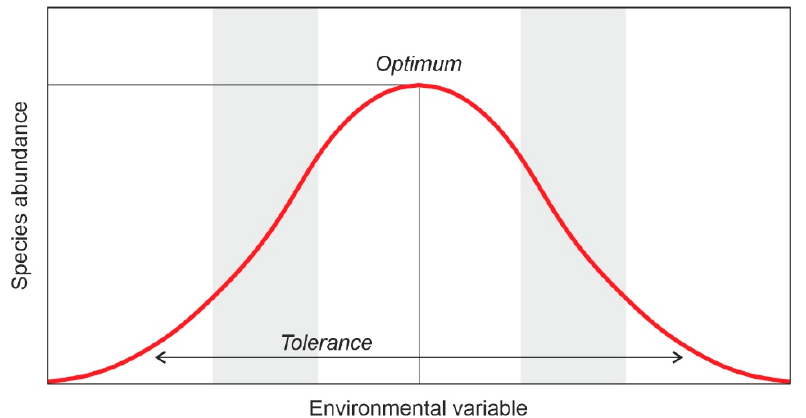
Figure 7. Gaussian curve displaying a hypothetical unimodal response of a species with respect to an environmental variable. The gray bands represent subranges of the environmental variable where the response may appear nearly linear. Redrawn and modified from [54].